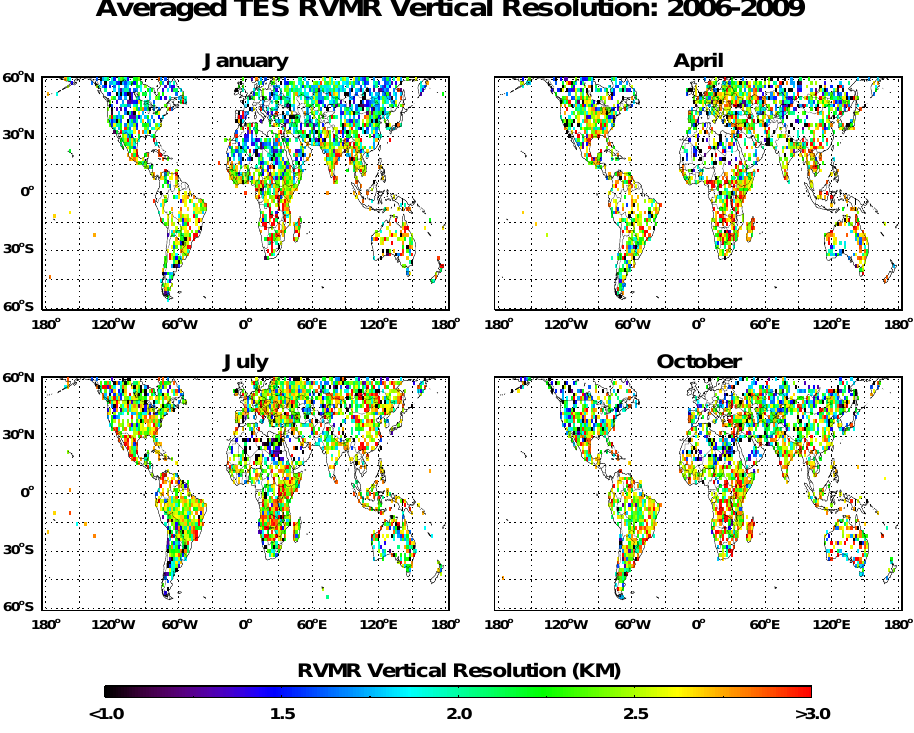
Fig. 21. The TES retrieval vertical resolution averaged over the 2 × 2.5 ◦ boxes corresponding to the RVMR values in Fig. 11.